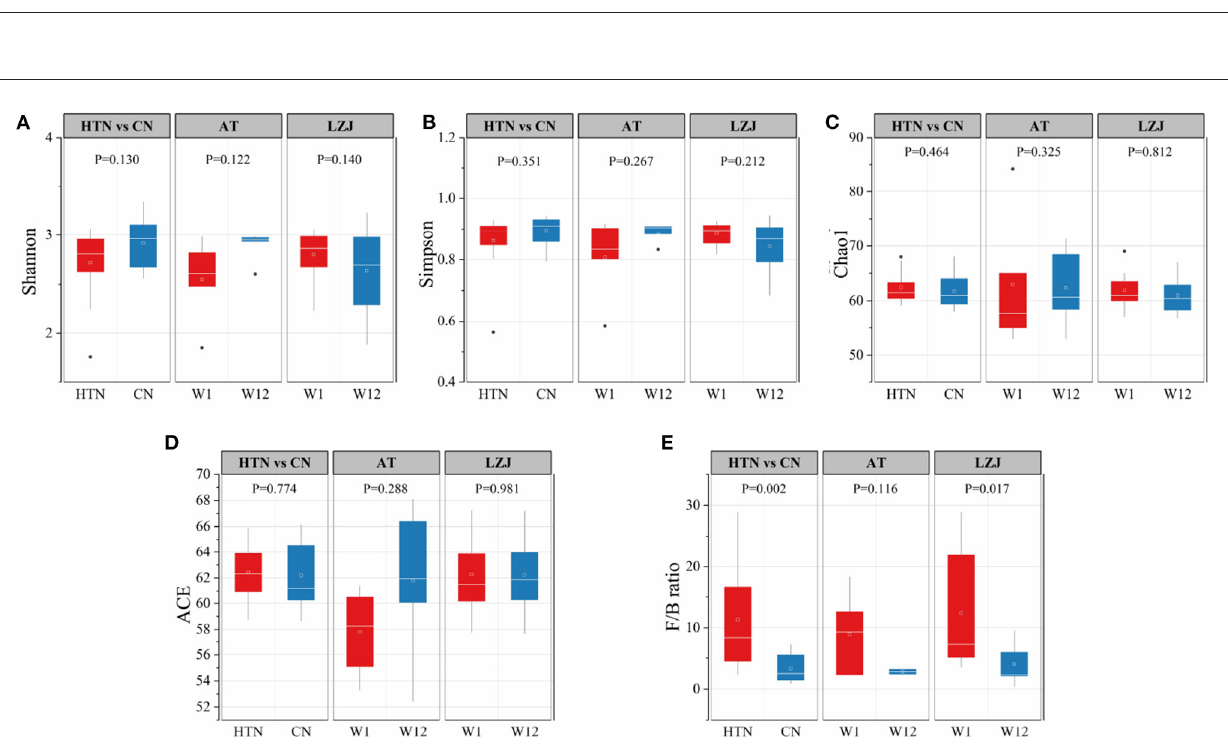
FIGURE5 Differences in the abundance and structure of gut microbiota. (A) Shannon index; (B) Simpson index; (C) Chao1 index; (D) ACE index; (E) F/B ratio; The line within the boxplot indicates the median. Whiskers are drawn to minimum and maximum values, but not further than 1.5 ×